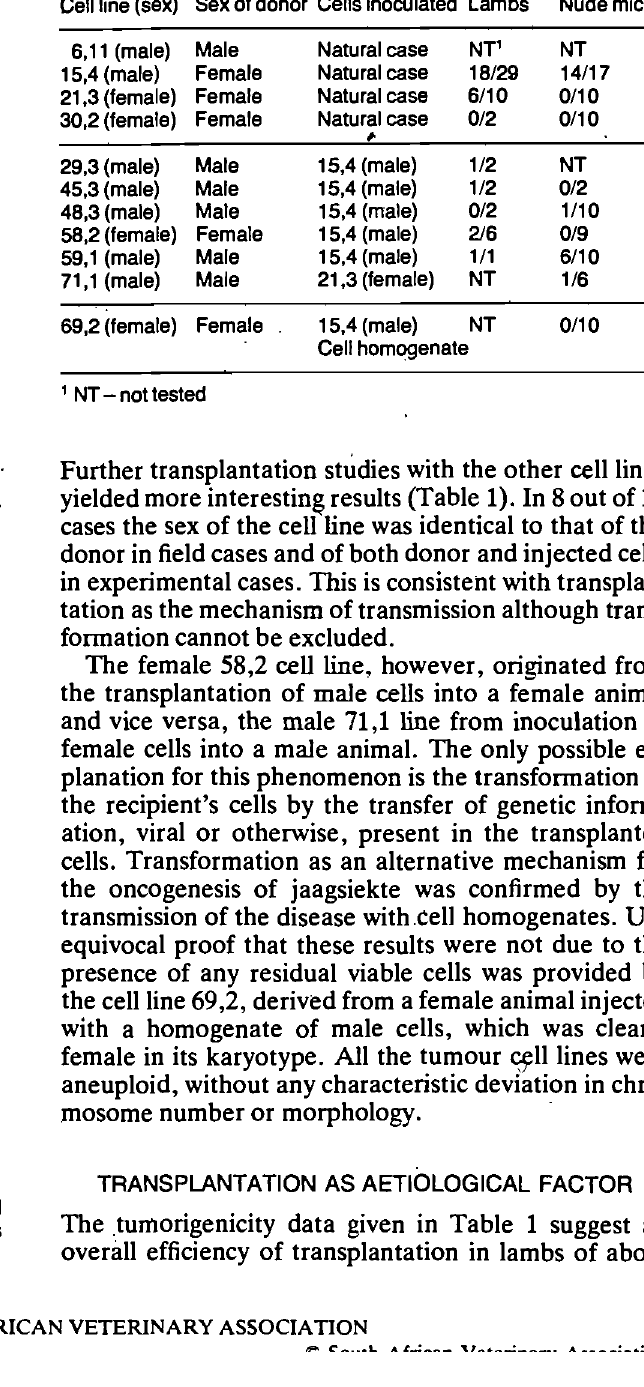
Table 1: EPITHELIAL CELL LINES ESTABLISHED FROM ADENOMATOUS OVINE LUNG TISSUE Tumours produced in Cell line (sex) Sex of donor Cells inoculated Lambs Nude